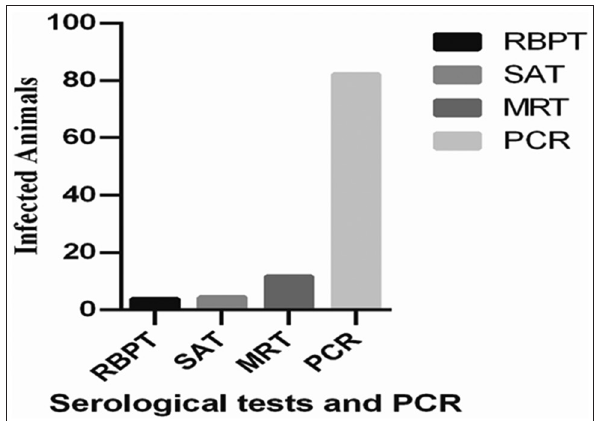
Figure-2: Overall brucellosis examined by different serological tests in 180 samples. The data expressed as percentage (100%). For abbreviation please see footnote of